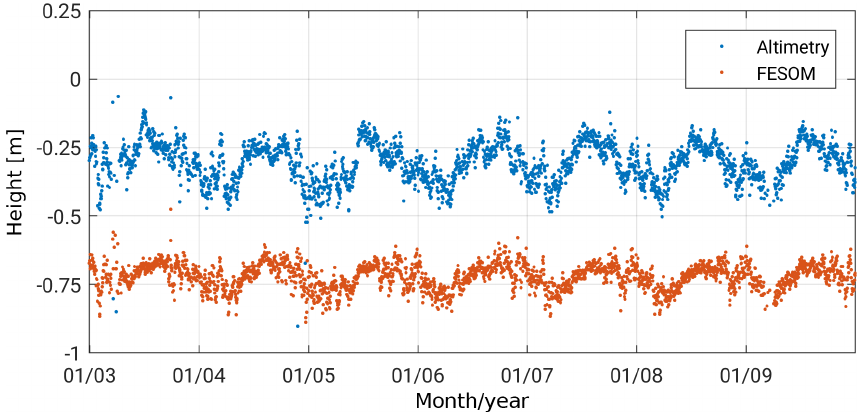
Figure 3. Temporal evolution of daily means of altimetry-derived DOT observations (blue) and FESOM SSH outputs (interpolated to the locations of altimetry measurements, red) within the investigation period and study area (see Sect.